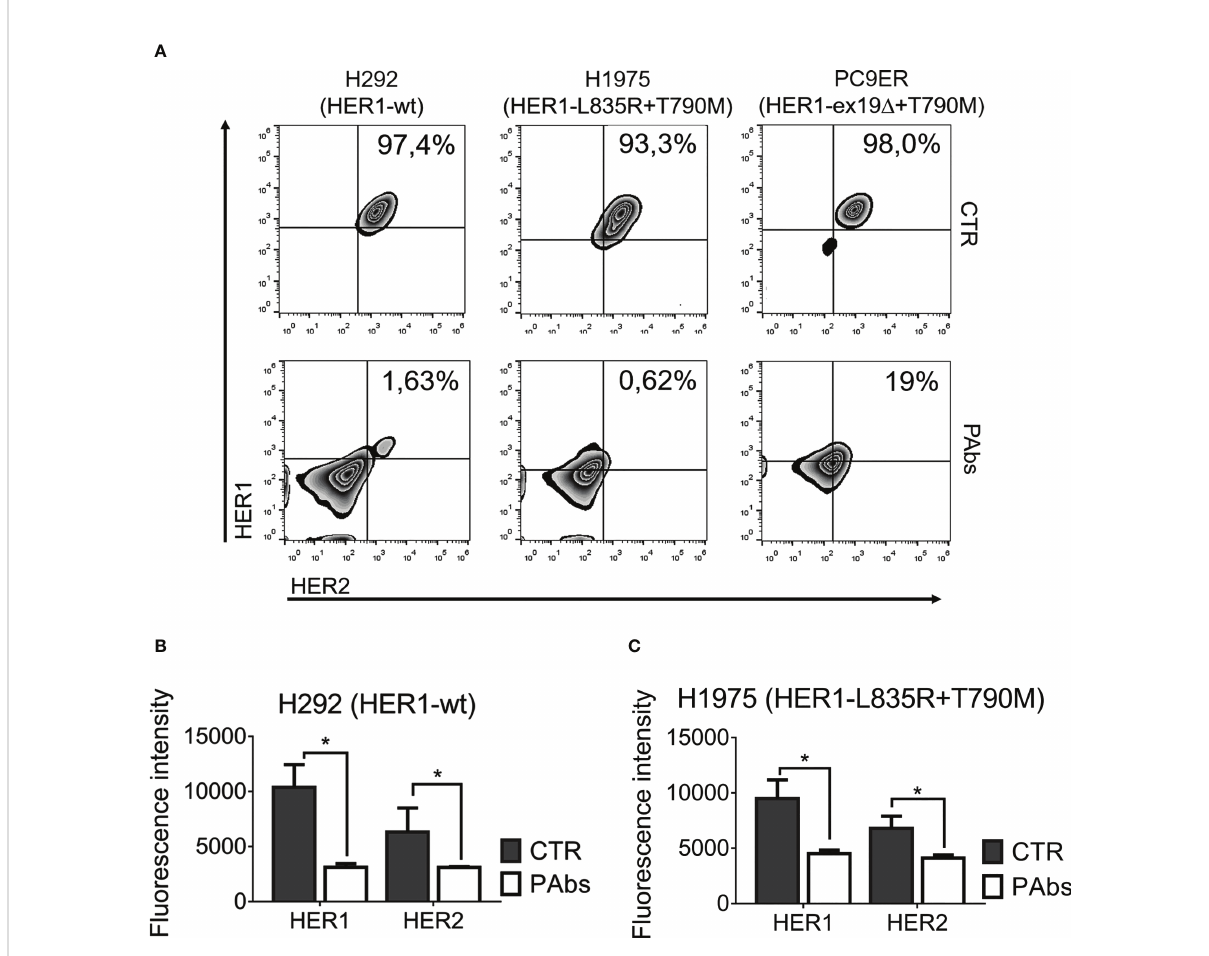
FIGURE 2 Promotion of the endocytosis and degradation of HER1 and HER2 by the PAbs. (A) H292, H1975, and PC9ER cells were treated for 24 h with PAbs-containing immune sera or pre-immune sera as negative control (1/100). After washing with acidic buffer (glycine 100 mM, pH 3.0), cells were incubated with antibodies against HER1 and HER2 tagged to fl uorophores, and surface expression of the receptors was analyzed using fl ow cytometry. Death cells were excluded with DAPI. Density plots show the distribution of the cell population according to recognition of HER1 ( y -axis) and HER2 ( x -axis), and the percentage of cells expressing both receptors is speci fi ed. Data are representative of two independent experiments. (B) H292 and (C) H1975 cells were seeded in coverslips and treated as in (A) for 24 h. Cells were washed in acidic buffer, fi xed in paraformaldehyde (4%), and incubated with speci fi c primary antibodies, followed by an Alexa Fluor 555 ‐ conjugated secondary antibody. Images were captured using a confocal microscope (40× magni fi cation) and quanti fi cation was performed using ImageJ software. In the graphs, data are means ± SD of triplicates in a representative experiment of three conducted. Means were compared using Kruskal – Wallis test followed by a Games – Howell post-test. Signi fi cant differences among control and PAbs-treated cells are represented * p <